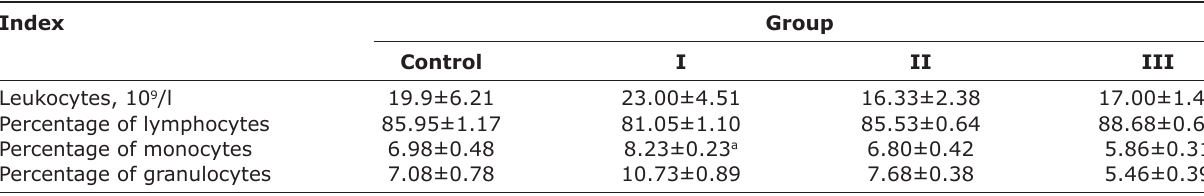
Table-3: The content of the white blood cells in broilers of cross “Smena 8” in the context of introducing Q. cortex